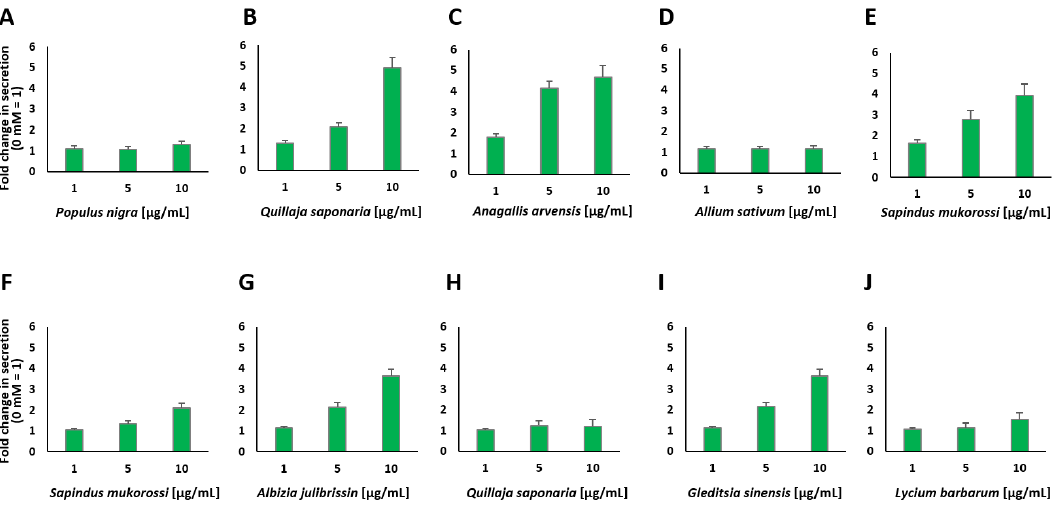
Figure 4. Insulin secretion from MIN6 β cells in response to stimulation with various concentrations of the indicated plant extracts ( A – J ). Fold change in the amount of secreted insulin expressed as luciferase activity from Ins-GLuc normalized to the activity of 0 mM glucose and expressed as fold change ± SEM ( n ≥ 8).